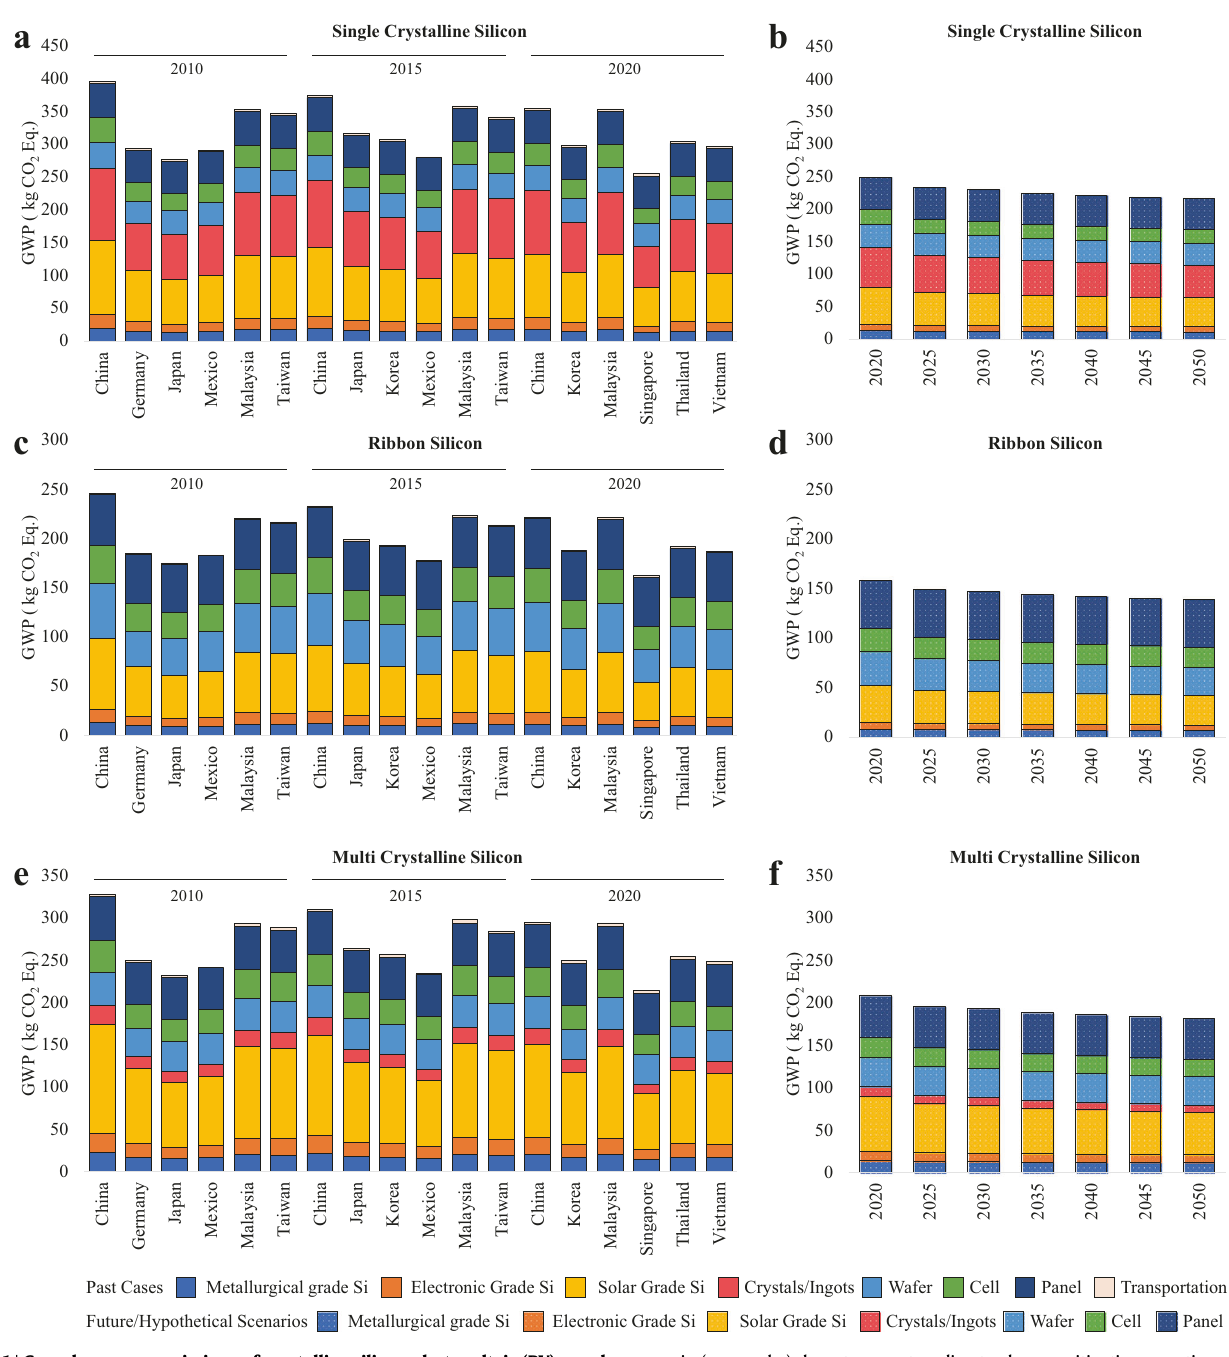
cases in ( a , c , and e ) do not guarantee climate change mitigation over time, as illustrated by the higher emissions in 2015 than in 2010 in some regions. To study theimpactofreshoringin2020,wecomparethe2020caseandthe2020scenario. The sources of PV supplies in the 2020 case include China, South Korea, Malaysia, Singapore, Thailand, and Vietnam, as shown in ( a , c , and e ). The PV panels in the 2020scenarioareonlymanufacturedintheU.S.,asshownin( b , d ,and f